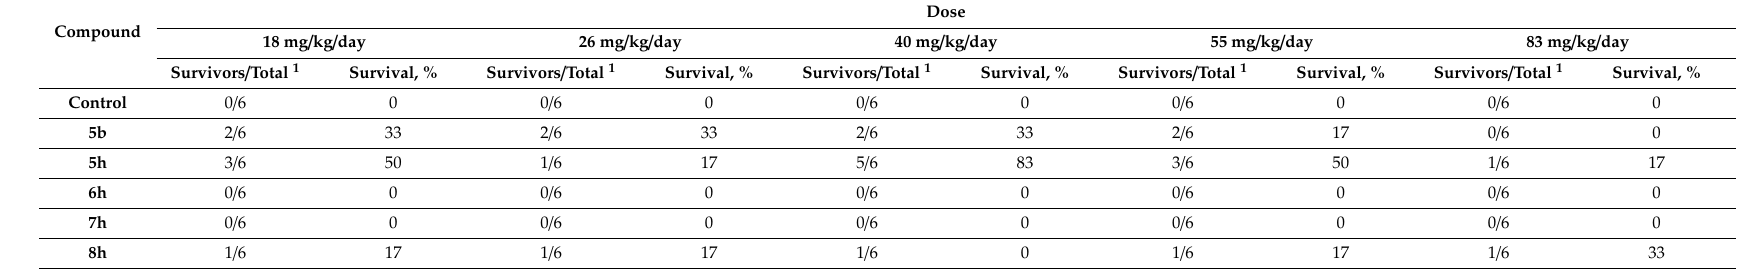
Table 4. E ff ect of compounds 5b , 5h , 6h , 7h , and 8h against i.p. implanted P388 murine